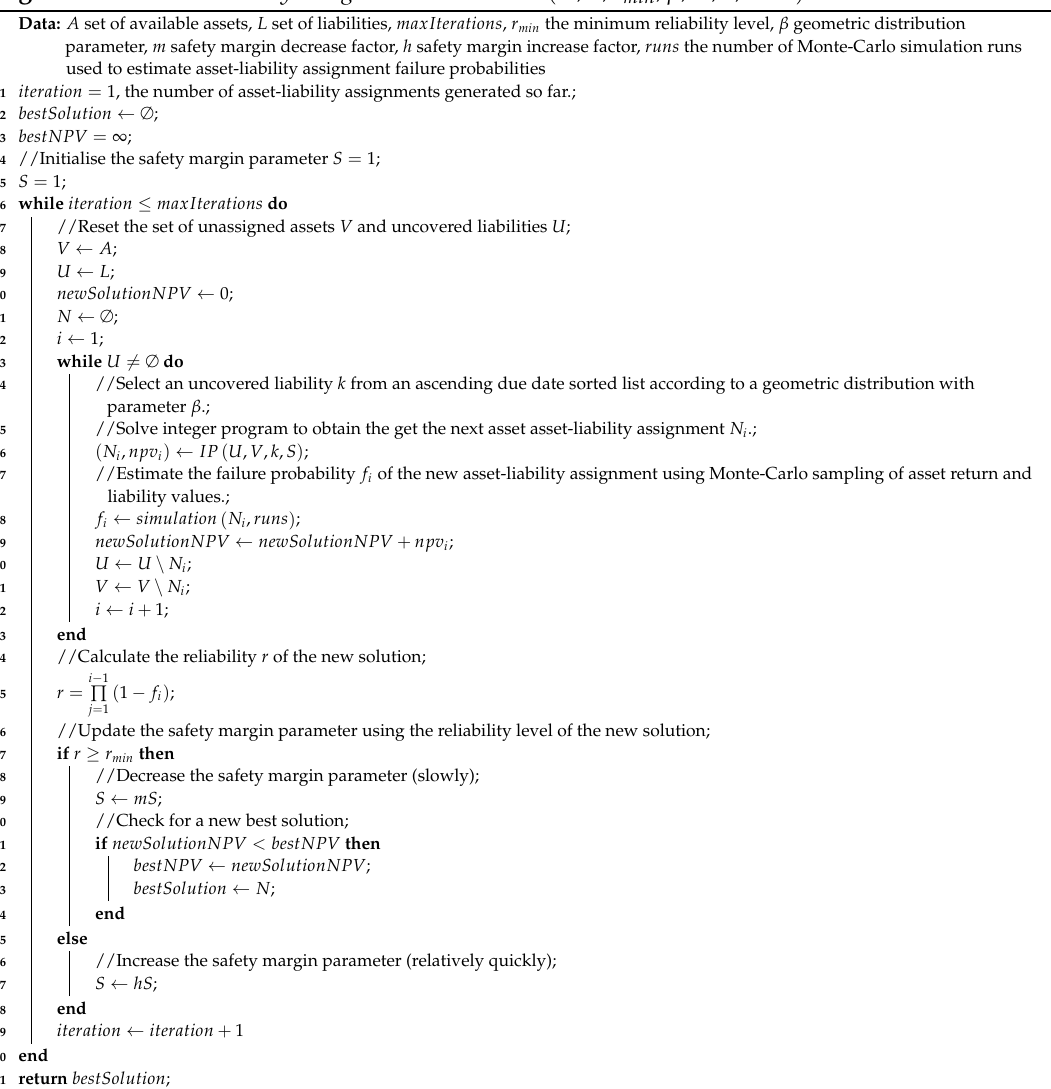
Algorithm 1: AssetLiabilityAssignmentGeneration ( A , L , r min , β , m , h , runs